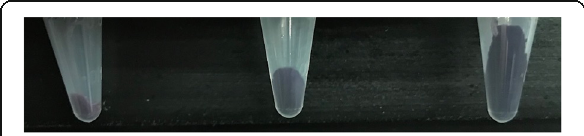
Fig. 10 Images depicting the precipitated fractions (highlighted in boxes) of centrifuged 5x-diluted dispersions with 1.25 SPI:sucrose ( A ) and 5:4 PPI:sucrose ( B ) and 0% (Left), 0.5% (Center, left), 1% (Center, right), and 1.5% PP addition